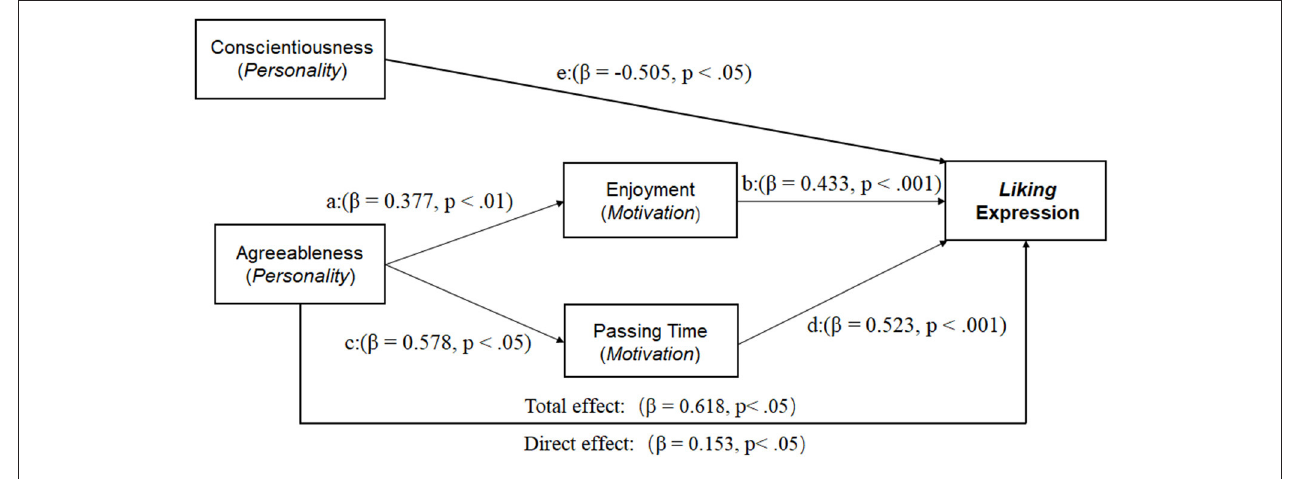
FIGURE 1 | Relationship between personality, motivation, and liking